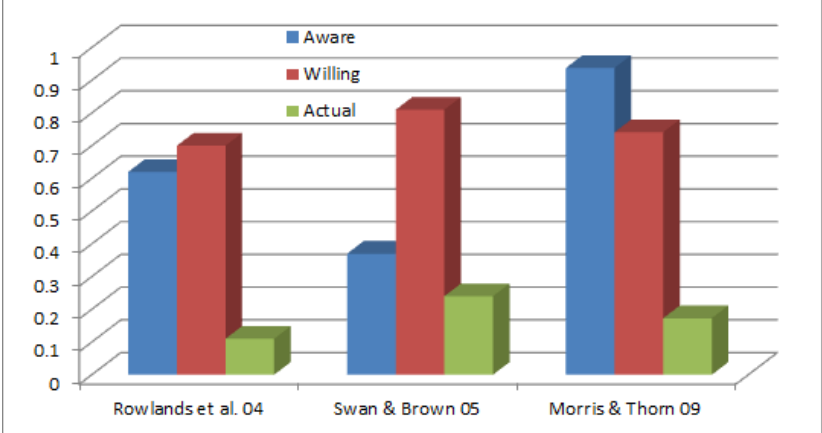
Figure 2. The divide between awareness and action for open access journal publishing [13–15].